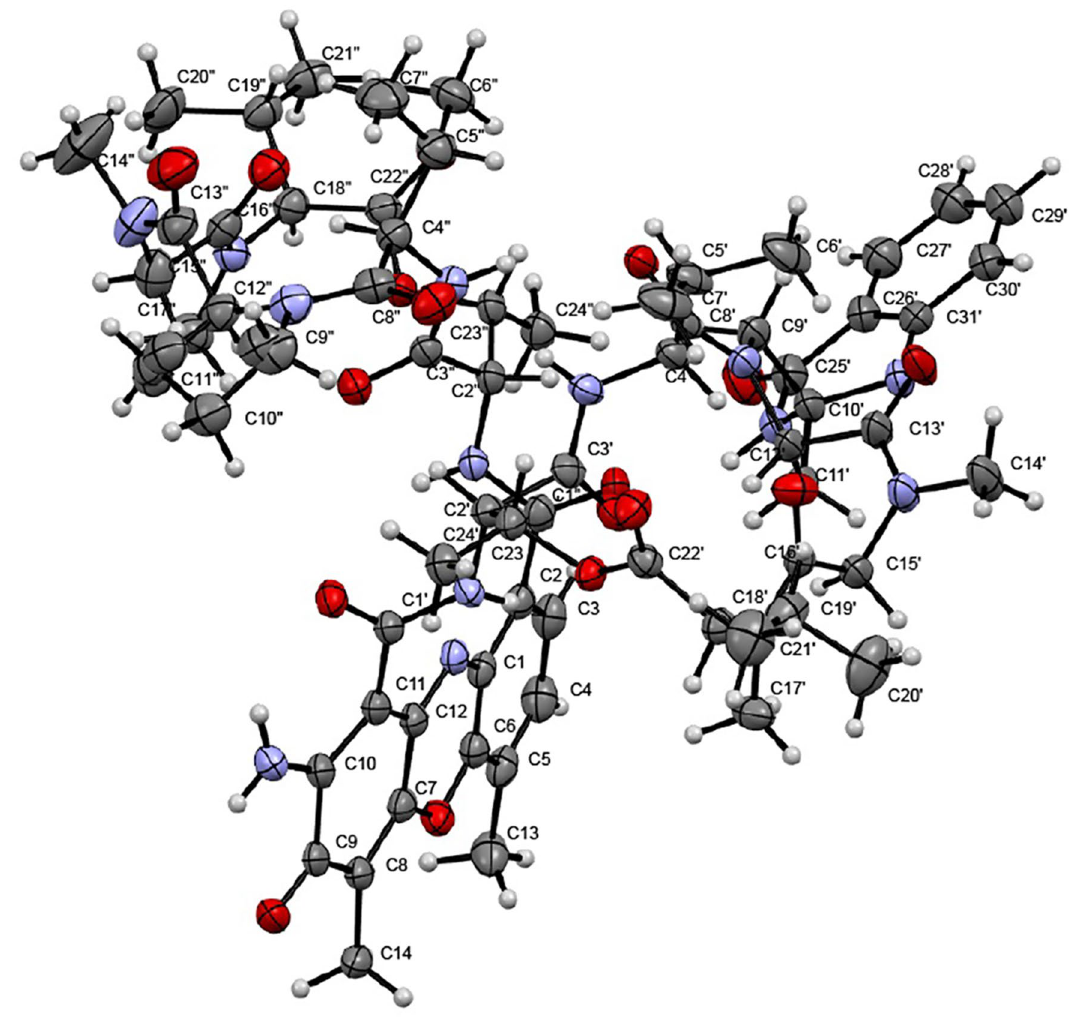
Figure 4. X-ray ORTEP drawing of the crystal structure of compound 2